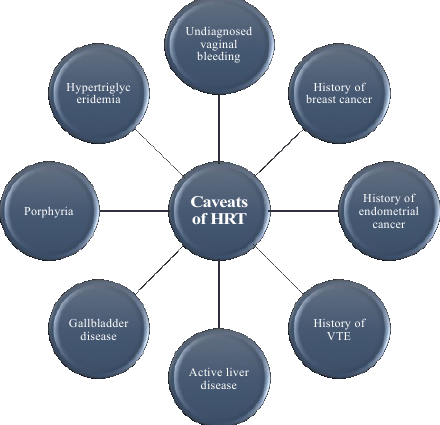
Figure 3. Relative contraindications to HRT.